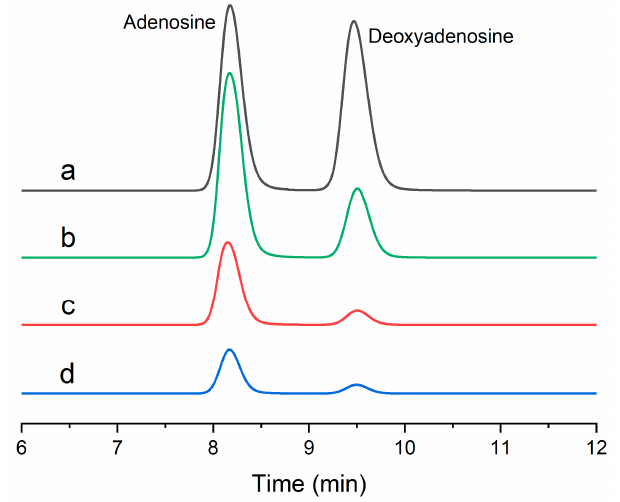
Figure 10. HPLC chromatograms of the mixed solution of adenosine and deoxyadenosine ( a ) and the chromatograms of the eluent for Fe 3 O 4 @MPS@MPBA ( b ), Fe 3 O 4 @MPTES@AAPBA ( c ) and Fe 3 O 4 @MPTES@VPBA ( d ) after being adsorbed in the mixture solution. Peak area ratio of adenosine to deoxyadenosine: 1:0.26 ( b ), 1:0.29 ( c ), 1:0.27( d ).